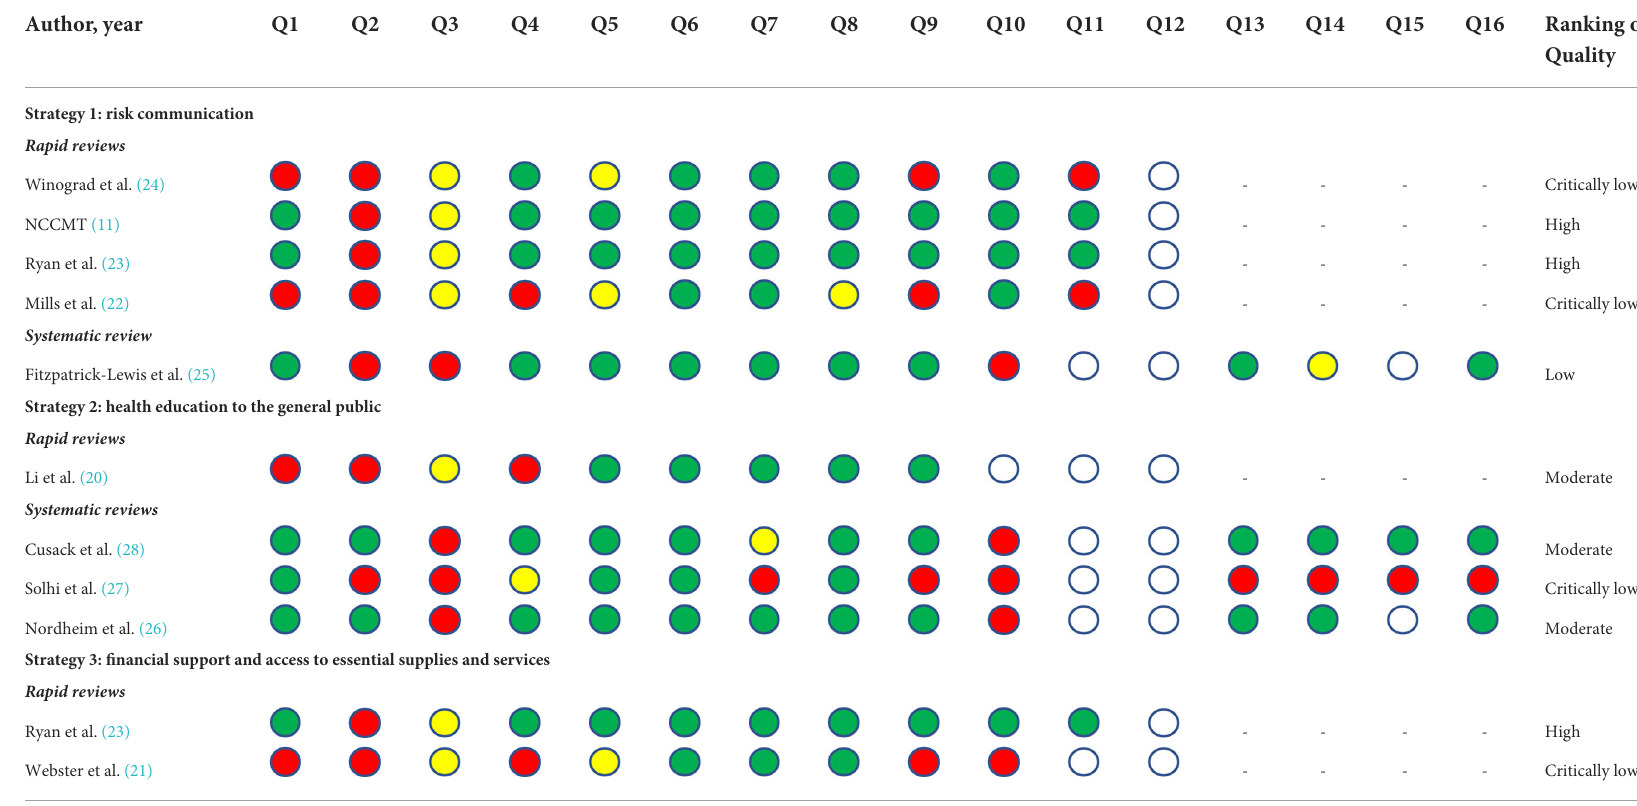
TABLE 2 Methodological quality of systematic reviews and rapid review according to AMSTAR 2 and adapted Cochrane checklist respectively. Author,